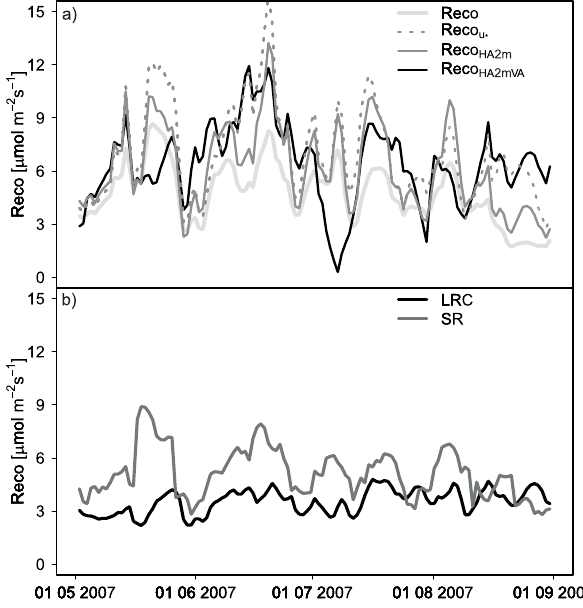
Fig. 9. (a) Daily medians of Reco for the period from May to Au- gust 2007. Reco is derived according to Reichstein et al. (2002, 2005) from (1) direct EC measurements (Reco), (2) filtered by u ∗ ≥ 0 . 3 (Reco u ∗ ) , (3) by incorporating (a) F HA2m (Reco HA2m ) and (b) F HA2m and F VA (Reco HA2mVA ) into the mass balance equation. (b) Daily median respiration values derived from soil respiration chamber measurements (SR) and light response curves